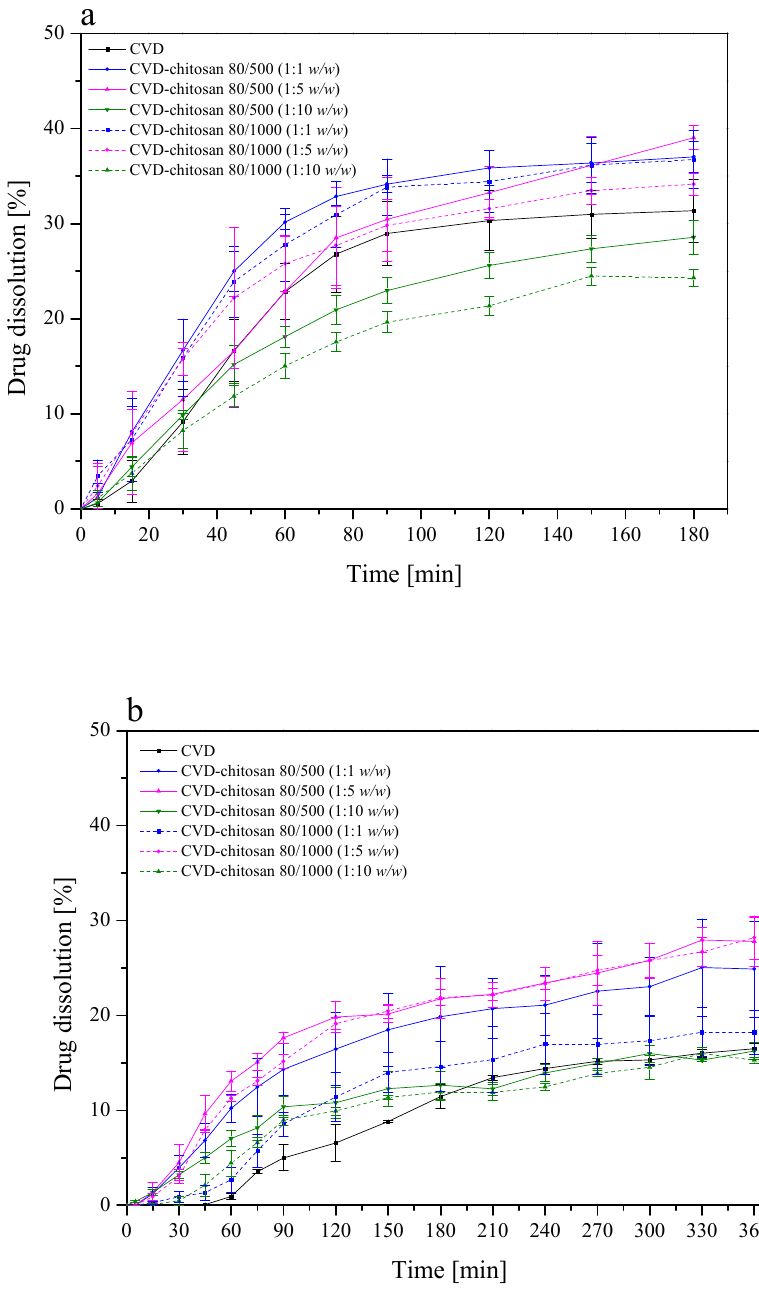
Figure 8. Powder dissolution of CVD from the chitosan systems at pH 1.2 ( a ) and pH 6.8 ( b ). Adhesive, topical delivery systems have been developed to be localized onto a bi- ological surface. Rheological measurements evaluated the mucoadhesive properties of chitosan-based systems with CVD. Chitosan is a compound possessing amino groups that interact with negatively charged mucin chains, mainly sialic acid in mucin, demonstrating a high interaction with mucin (Figure 9) [52]. The bioadhesion increased with increasing system viscosity (chitosan 80/1000 > 80/500) and chitosan in the system. The increase in bioadhesion has both advantages, such as increased membrane adhesion and prolonged contact time of the product with the mucosa; however, it has serious disadvantages, such as the prolonged and limited release of the active compounds from the drug delivery system.